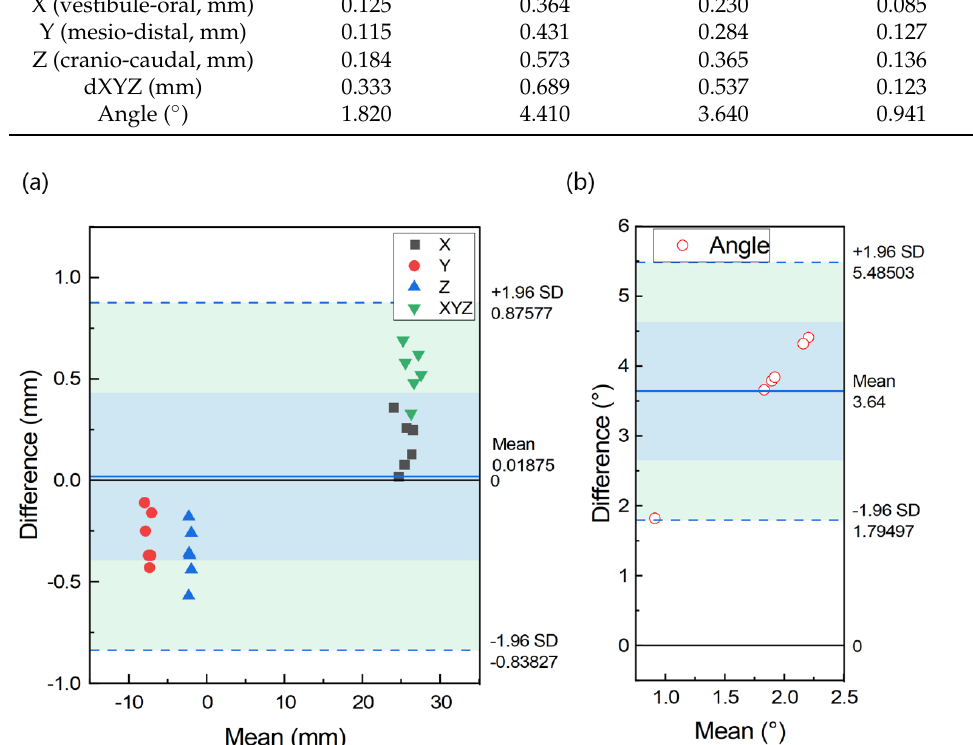
Figure 4. Bland ‐ Altman plot indicating distribution of difference between designed and placed po ‐ Figure 4. Bland-Altman plot indicating distribution of difference between designed and placed sition on all dimensions ( a ) and angular ( b ) of different cases. position on all dimensions ( a ) and angular ( b ) of different